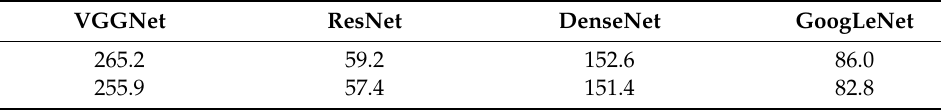
Table 6. The average training time for one